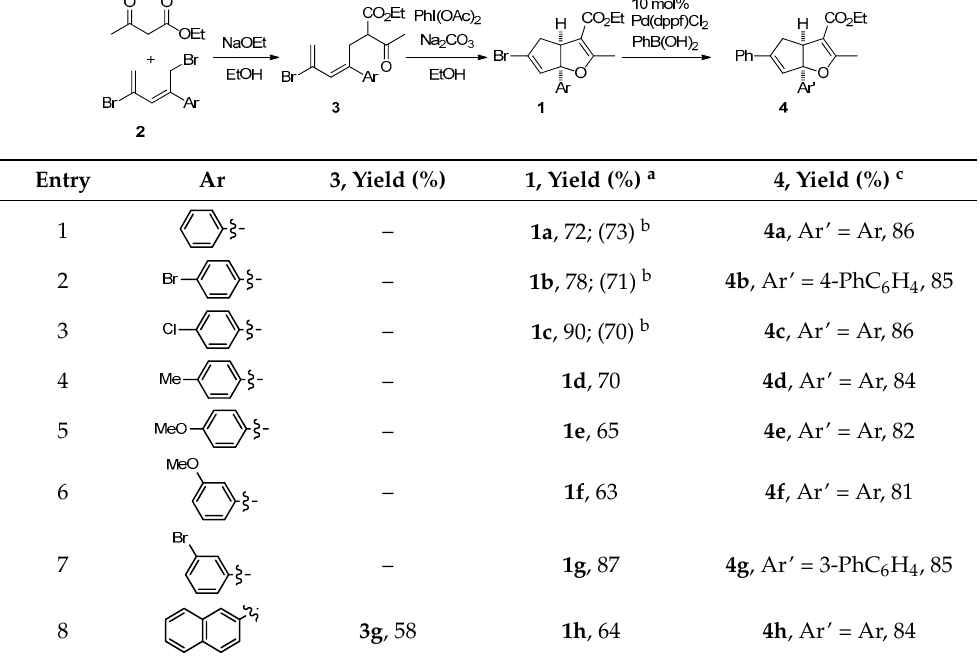
Table 1. Synthesis of cyclopenta[ b ]furans.